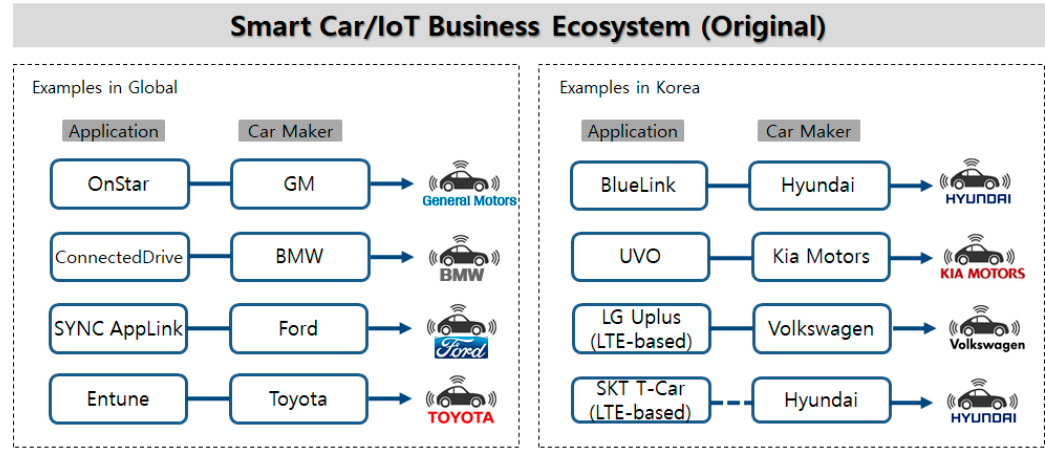
Figure 4. Original Smart Car/IoT business ecosystem.